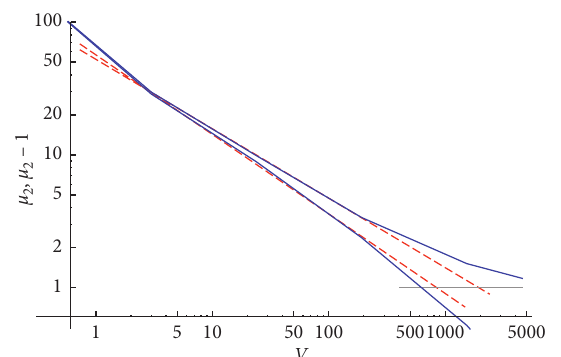
Figure 1: Fits to scaling for sample VLS1: moments μ ( v ) and 2 ( v ) − 1 ( v in Mpc 3 /h 3 ), with fits to the scaling ( v / v ) − c /3 , rep- μ 0 2 resented as dashed lines. The crossing of each dashed line with the horizontal gray line gives v 0 Figure 1 refers to a volume-limited sample of 1765 galaxies in the redshift range ( 0 . 003 , 0 . 013 ) , defined by Gaite [15] and called VLS1. This sample was adequate to compute a quite complete multifractal spectrum and is now useful to test the two options for the scaling law that yields D . The 2 − 1. solid blue lines in Figure 1 are the graphs of μ and μ 2 2